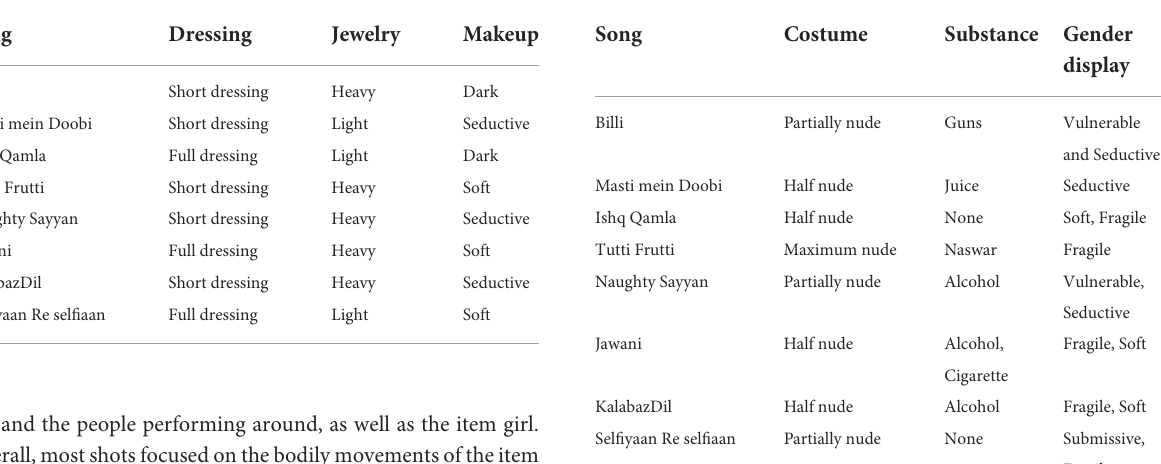
TABLE 3 Dressing, jewelry, and makeup in item songs. TABLE 4 Costumes, substance, and gender